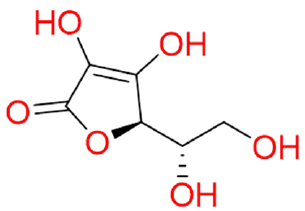
Figure 2. 2D structure of ascorbic acid (Vitamin C).